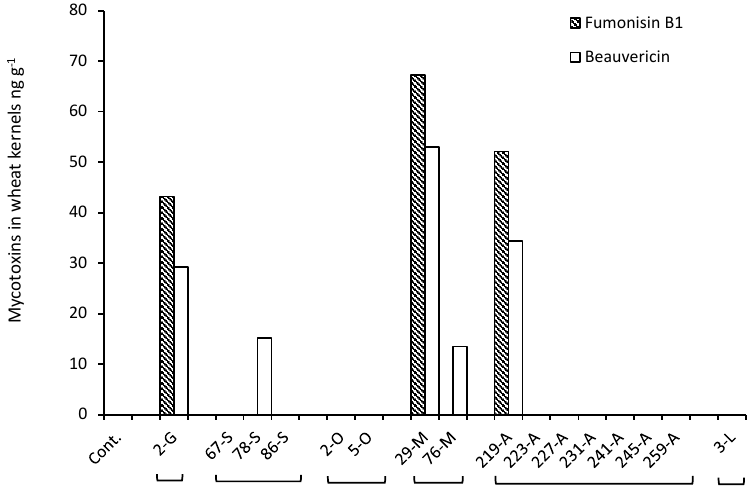
Fig. 4. Fumonisin B and beauvericin quantification in colonized wheat kernels 1 infected by different tested F. proliferatum strains with soak-inoculation